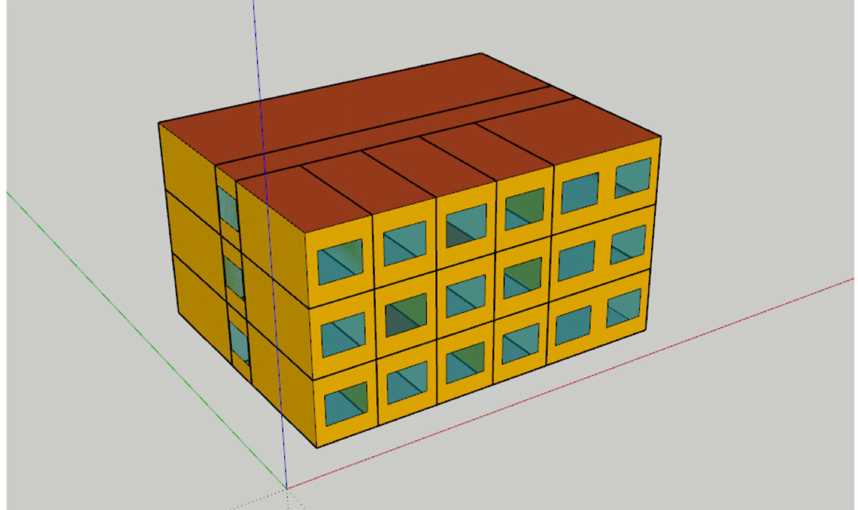
Figure 2. External structure of dormitory